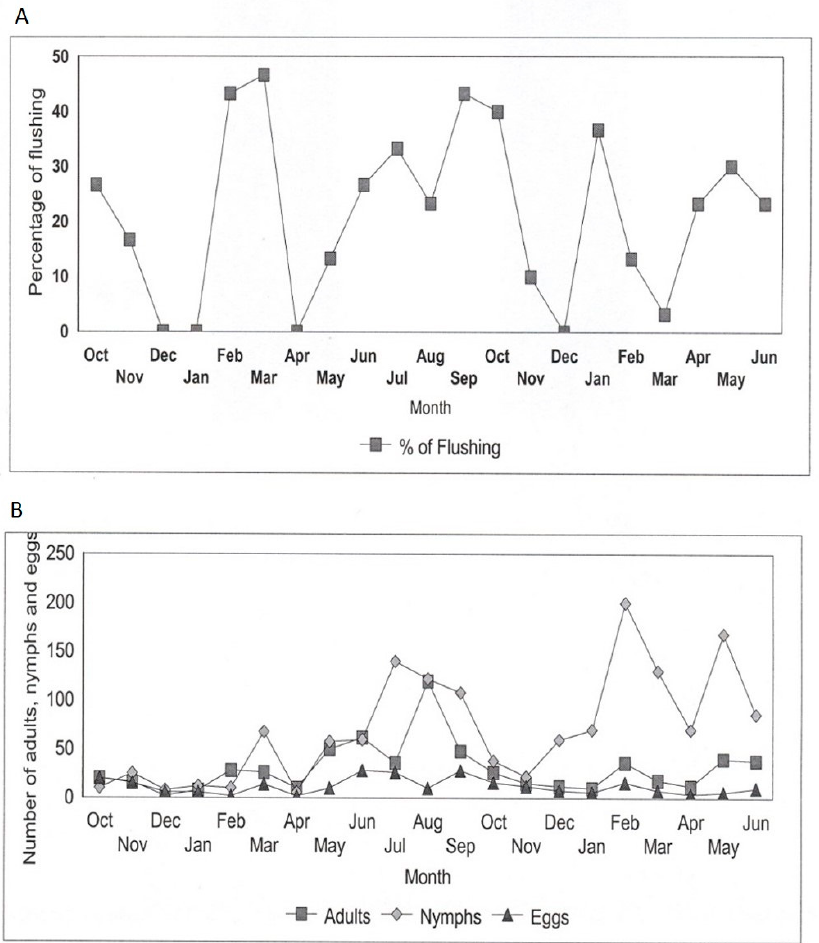
Figure 1. Seasonal variation in D. citri population abundance relating to flushing cycle from October 2012 to June 2013 in a citrus orchard; ( A ) Percentages of flushing; ( B ) Numbers of adults, nymphs, and eggs.